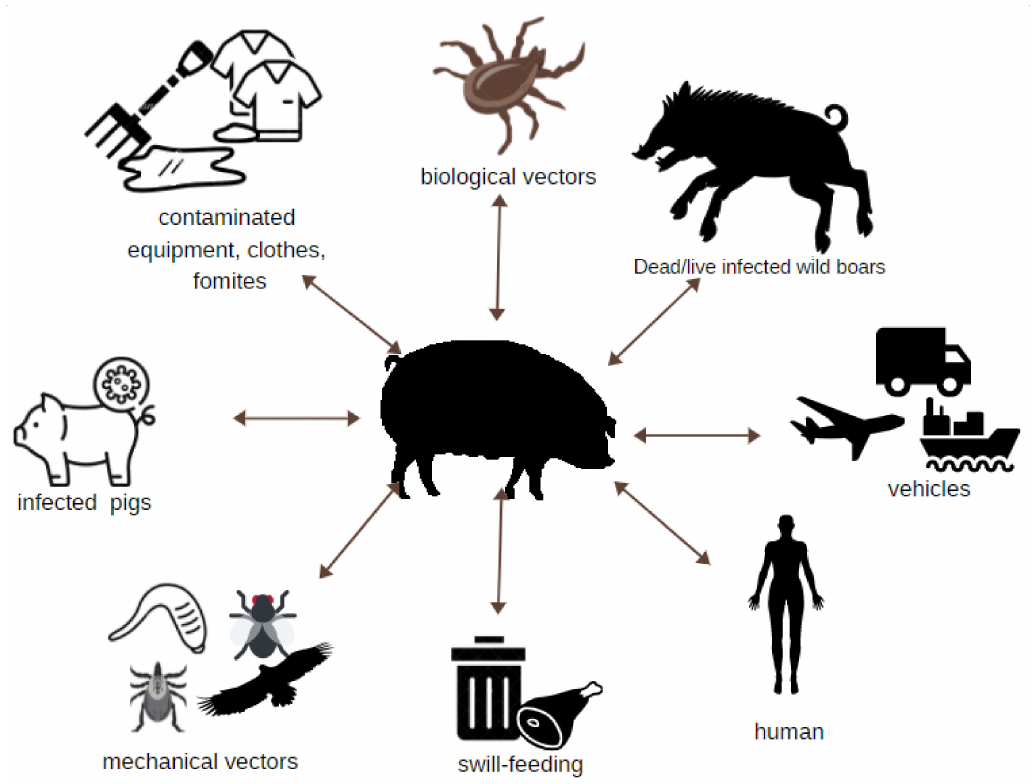
Figure 2. Potential routes of ASFV transmission to